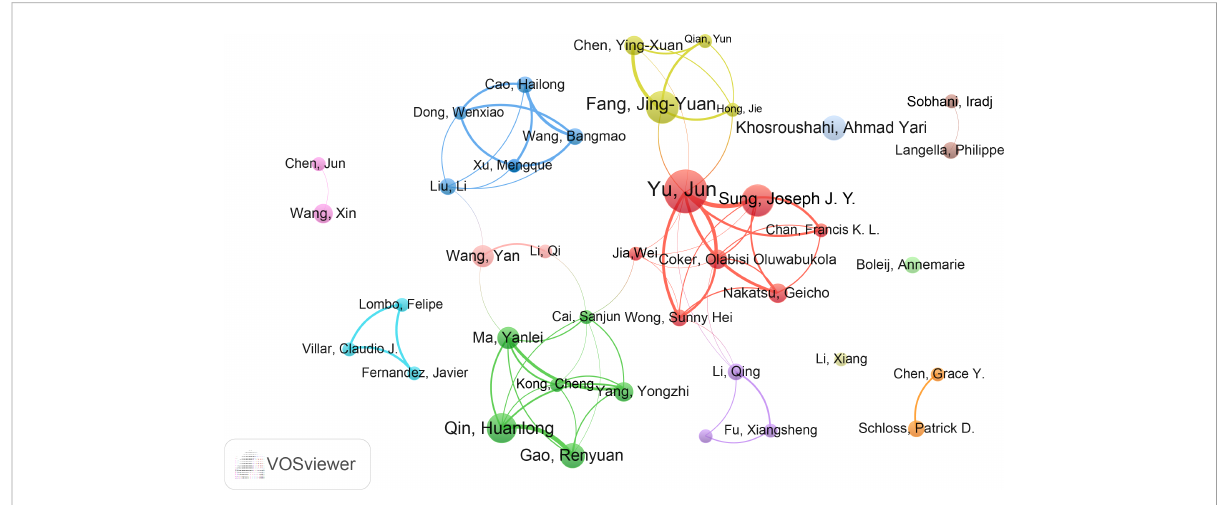
FIGURE 5 The cooperation network of authors in the fi eld. Dots represent authors, with larger dots indicating a high number of publications, clusters are marked using different colors and links represent cooperation between authors.